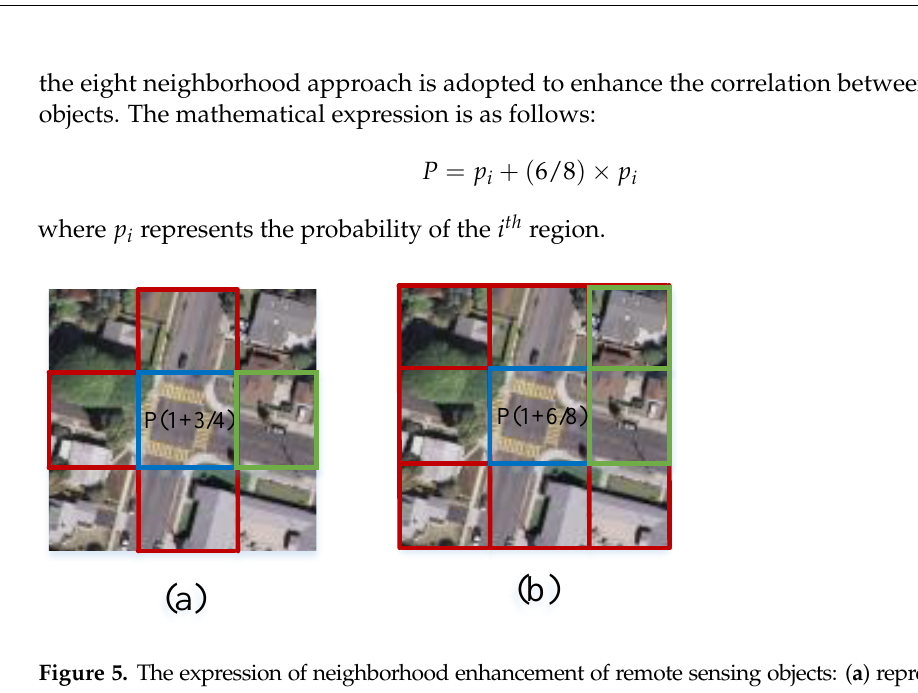
Figure 5. The expression of neighborhood enhancement of remote sensing objects: ( a ) represents four neighborhoods; ( b ) represents eight neighborhoods, P represents